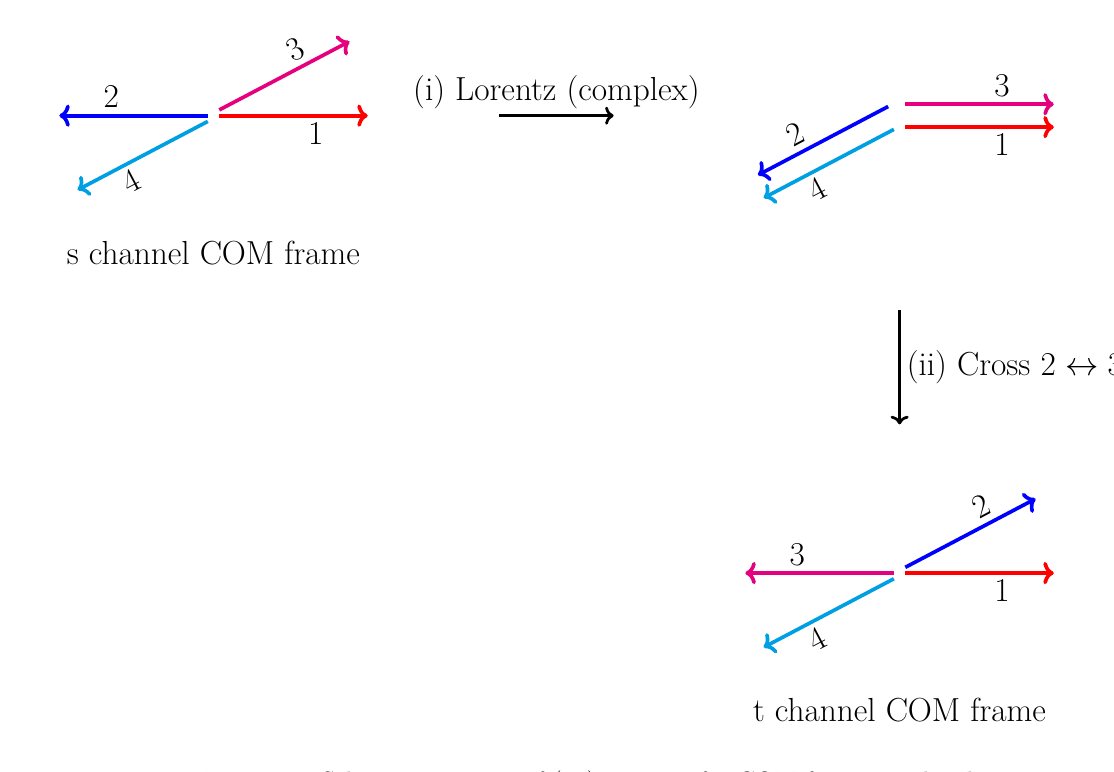
Figure 12 . Schematic picture of (23) crossing for COM frame